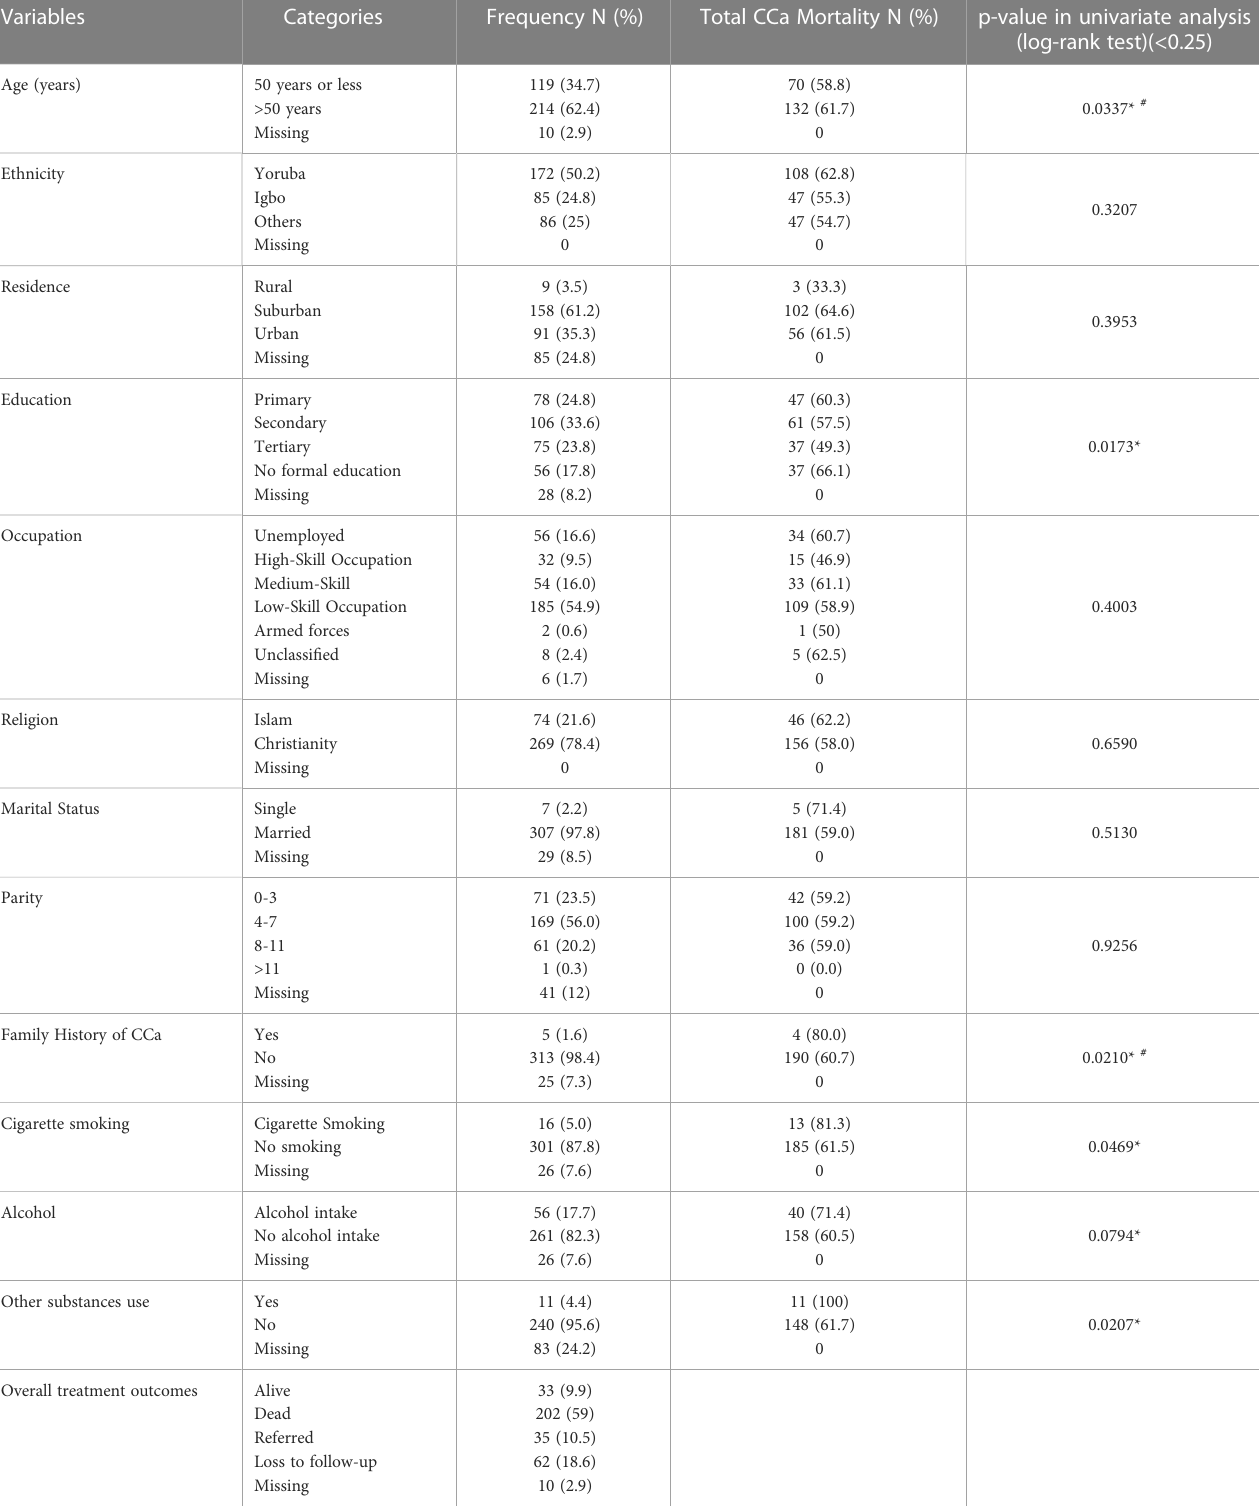
TABLE 1 Non-clinical characteristics of the study population including results of univariate